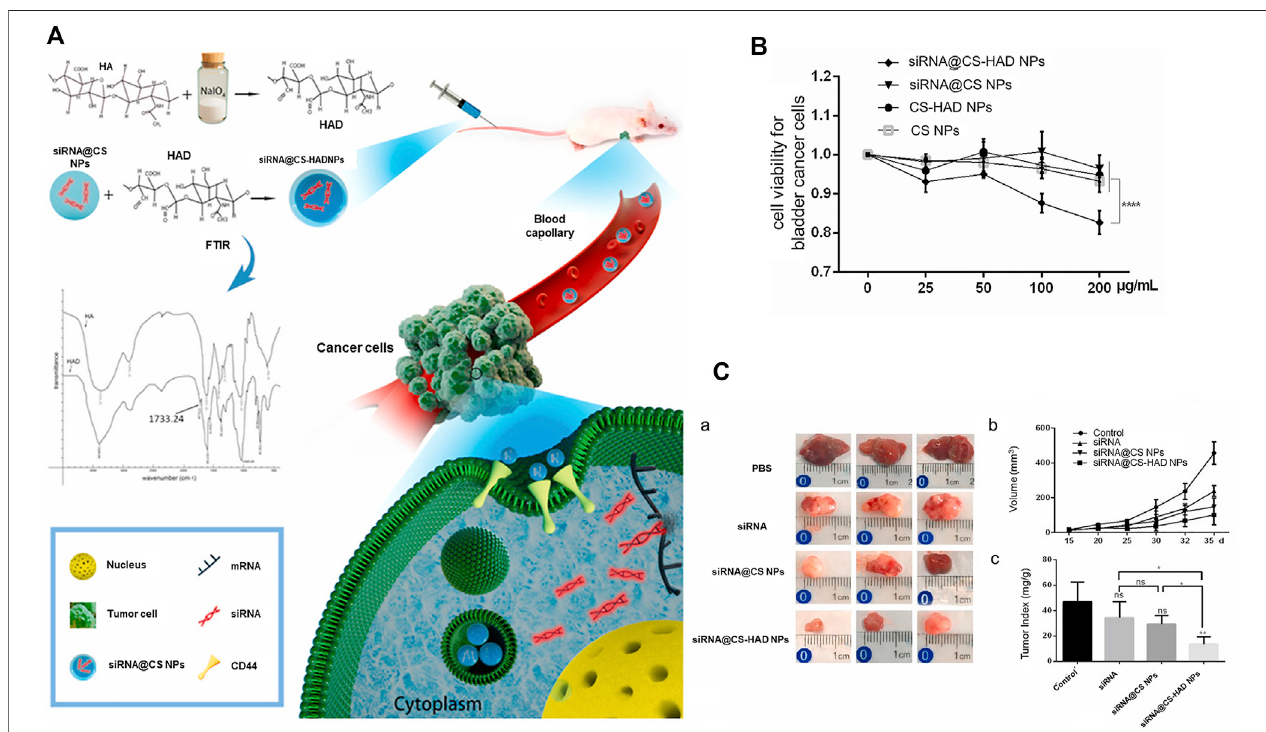
FIGURE 9 | Hyaluronic acid-modi fi ed chitosan nanoparticles delivering targeted siRNA therapy for BC. (A) Schematic diagram of targeted delivery of siRNA for treatment of BC. (B) Viability of T24 BC cells treated with four types of nanoparticles for 96 h. (C) a: Images of bladder tumors after different treatments collected from sacri fi ced mice after the experiment. b: Regular measurements of changes in body weights of mice, c: Ratio of tumor weight to body weight. Reproduced with permission from (Liang et al., 2021).